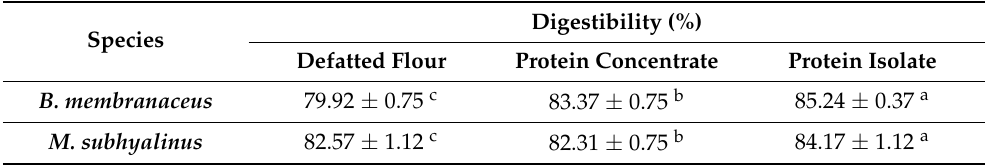
Table 7. Digestibility (%) of defatted flour, concentrates, and isolates of Brachytrupes membranaceus and Macrotermes subhyalinus .